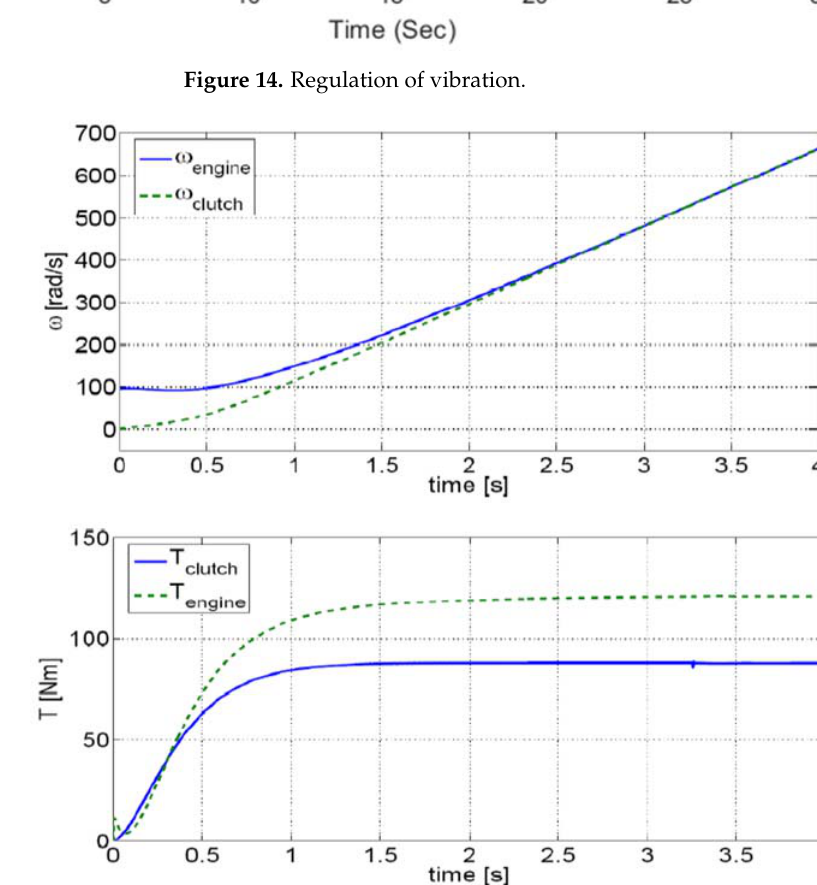
Figure 15. Clutch engagement and torque transmission.